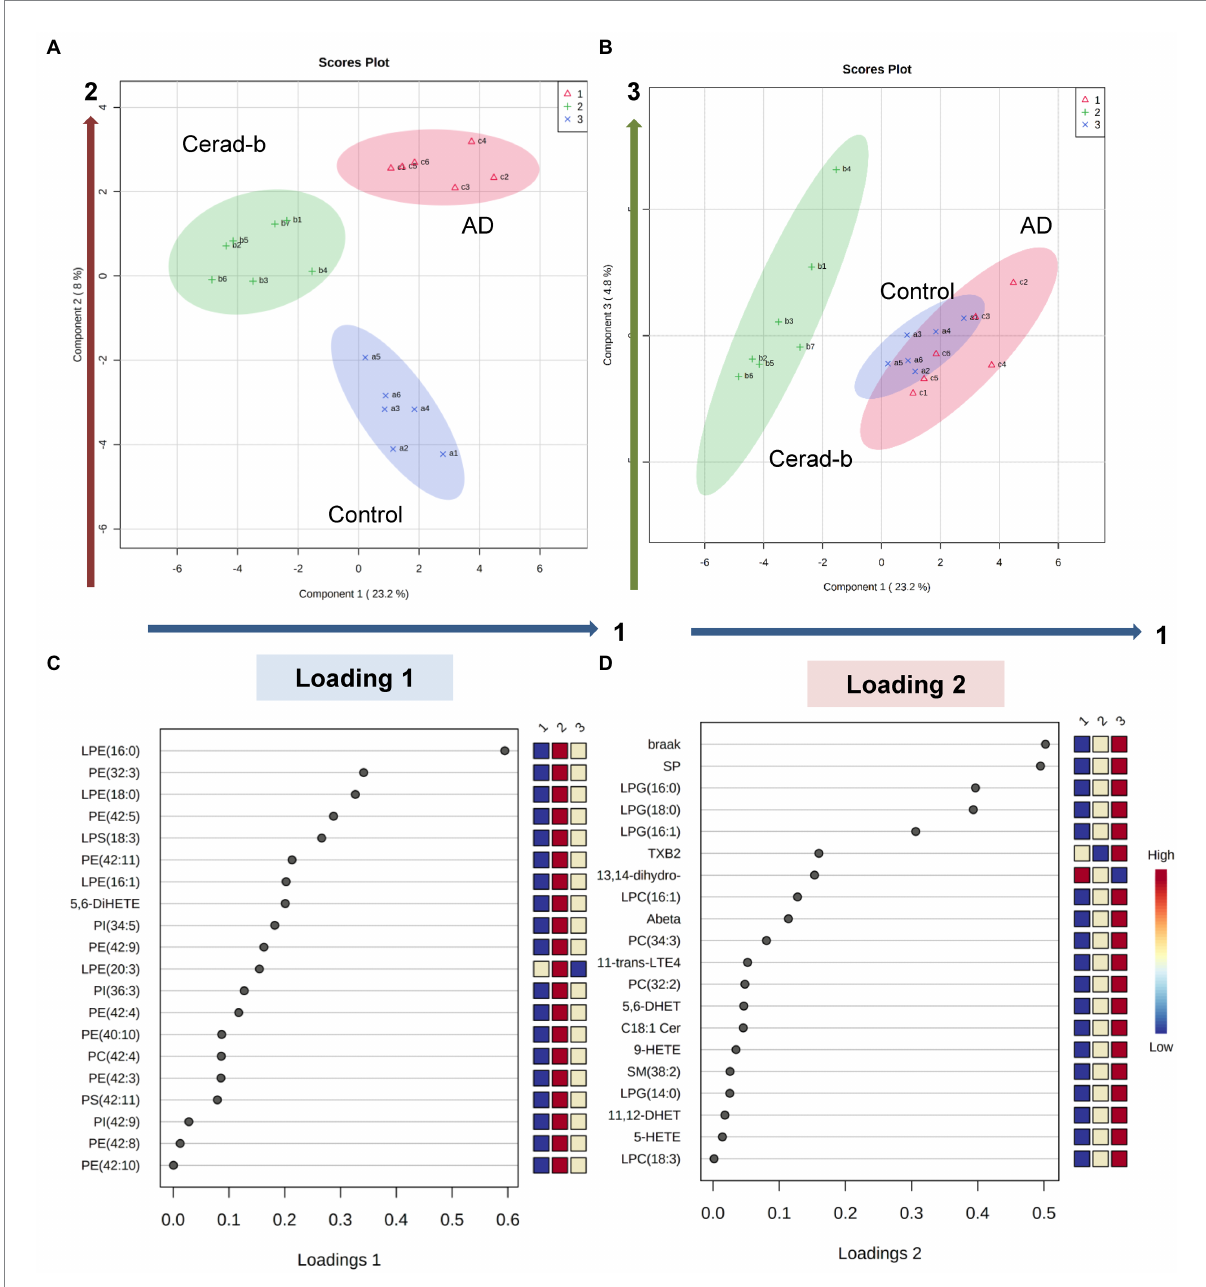
FIGURE 6 Discriminant analysis using the brain levels of bioactive lipids for diagnostic groups. Sparse PLS-DA was performed to identify bioactive lipids that contribute to discriminating AD from Cerad-b and control, and those that contribute to discriminating AD and Cerad-b from control. (A,B) Score plots. (C) Loading plot for component 1. (D) Loading plot for component